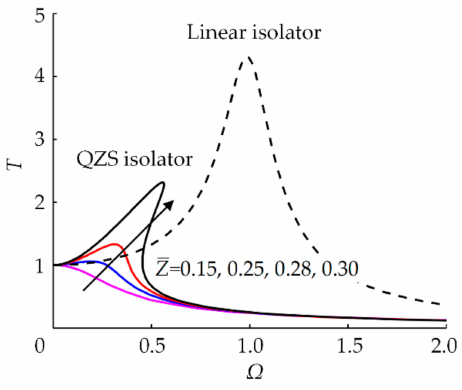
Figure 13. E ff ects of excitation amplitude Z on displacement transmissibility T